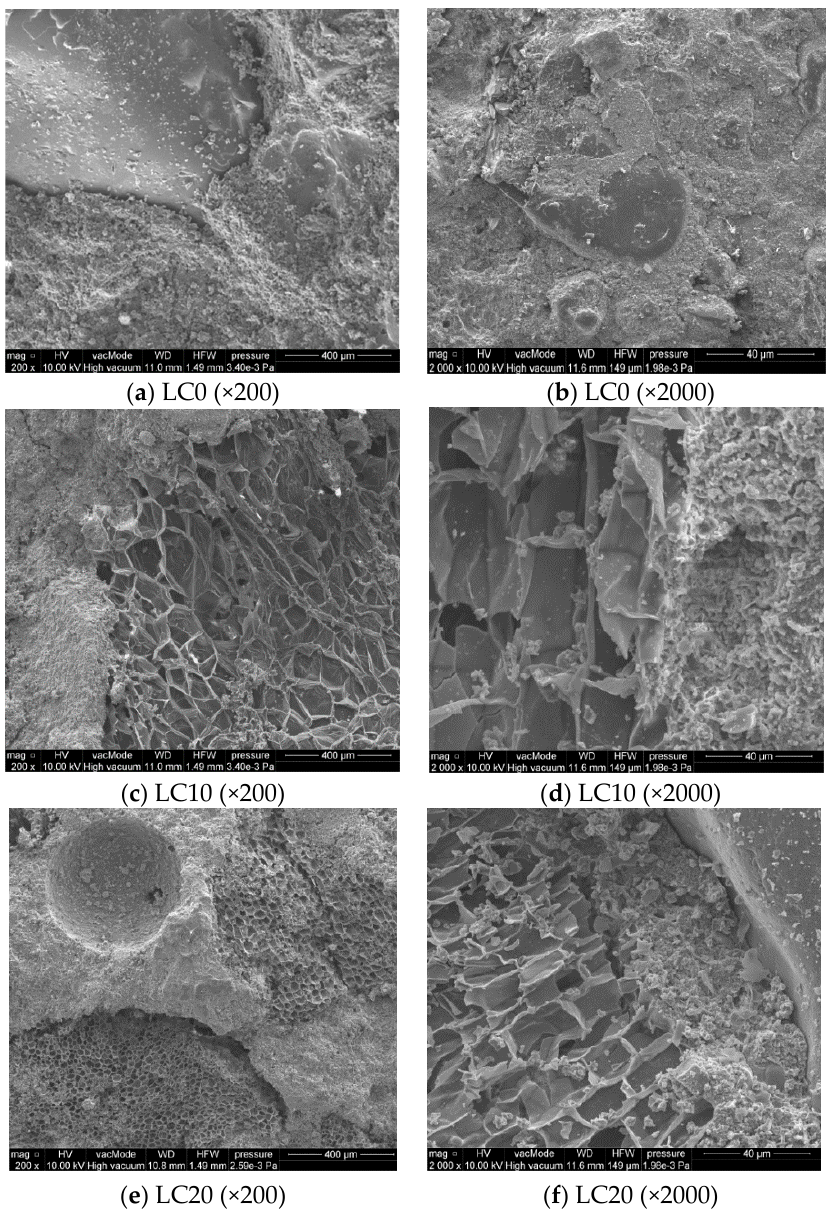
Figure 7. Internal microstructure of LC without/with EPS. ( a ) LC0 (×200); ( b ) LC0 (×2000); ( c ) LC10 (×200); ( d ) LC10 (×2000); ( e ) LC20 (×200); ( f ) LC20 (×2000).